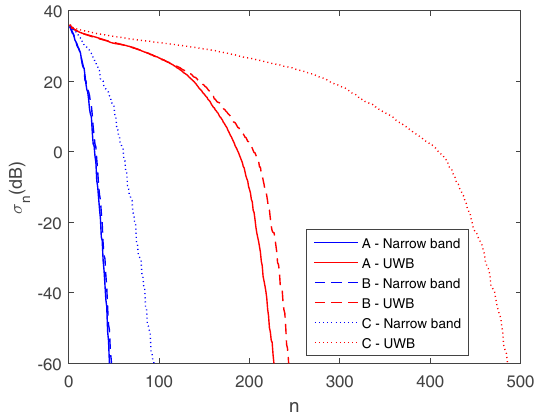
Figure 4. Singular values (in decibels) of the radiation operator for the sensing strategies A, B, C in the narrow band and Ultra Wide Band (UWB) cases.